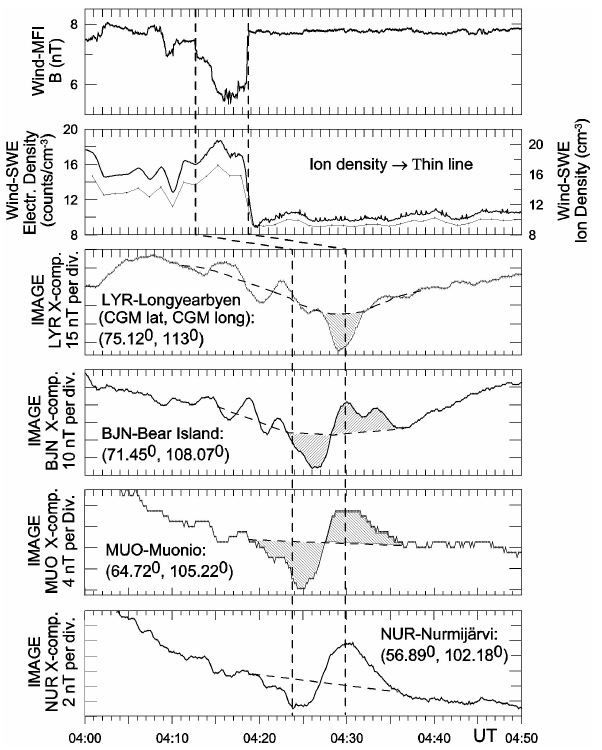
Fig. 3. The two vertical dashed lines define the ∼ 6-min duration solar wind pressure pulse that occurred on 3 July 1997. Measure- ments obtained by the MFI magnetic field experiment, the 3DP and SWE plasma instruments on board Wind, and the associated ground signatures from the IMAGE array stations are shown from top to bottom. The pressure pulse produces bipolar features with progres- sively decreasing amplitudes at progressively lower CGM latitude stations. Along the highest latitude LYR station trace the periodic oscillations are mixed with the bipolar feature and only the negative excursion is very clear.